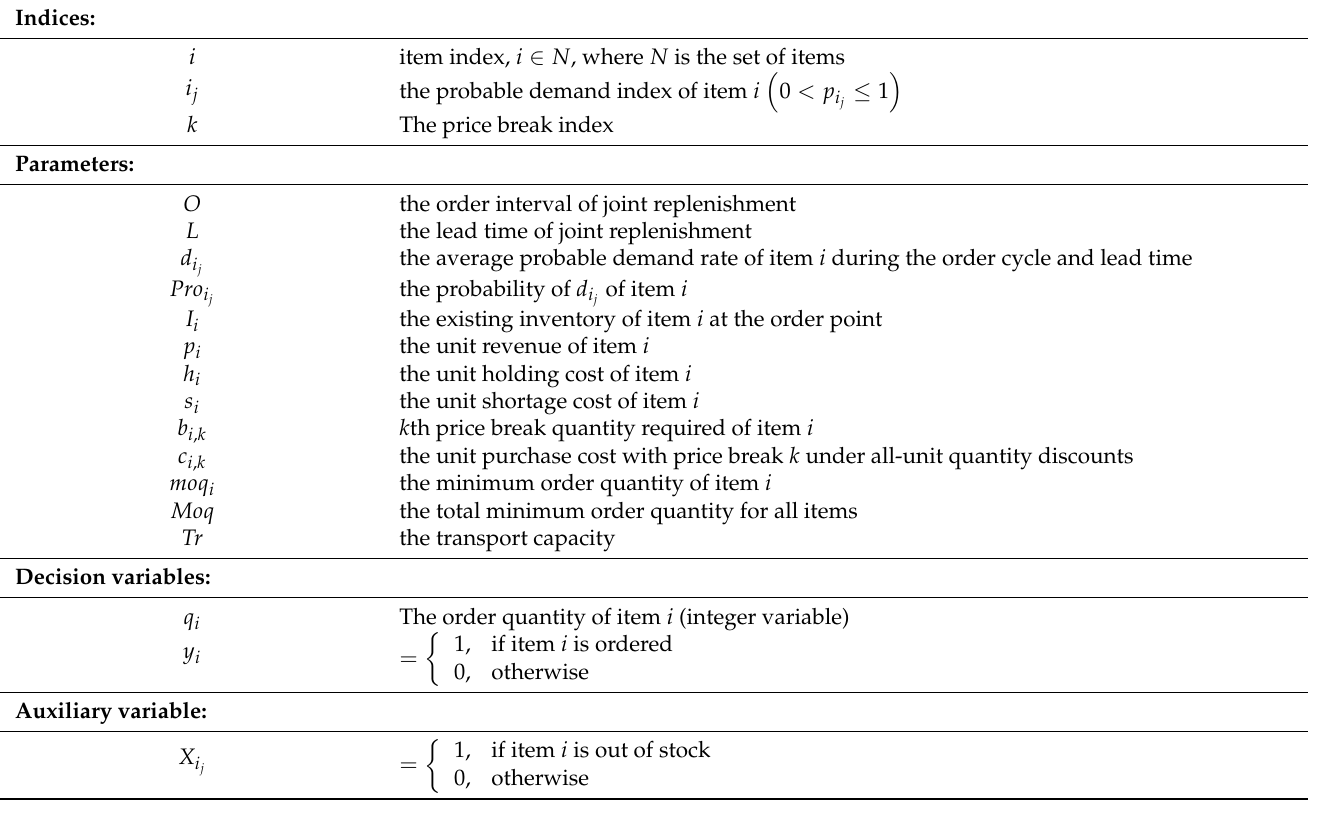
Table 2. Description of